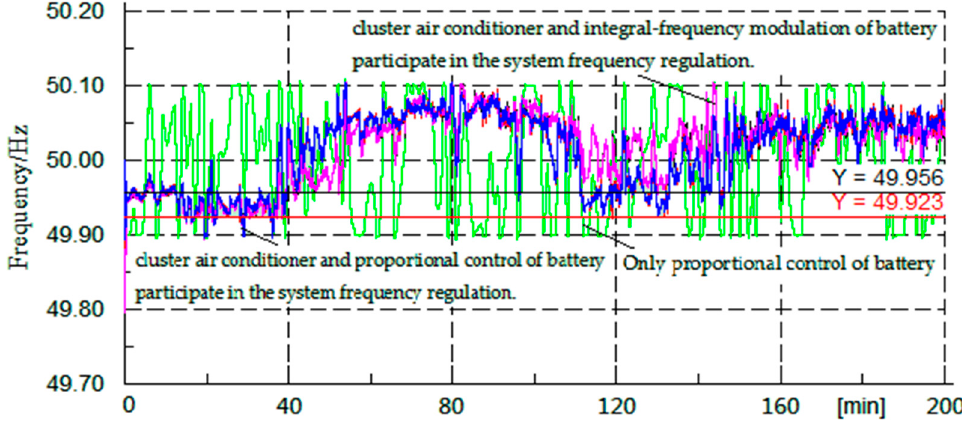
Figure 8. The system frequency curves with different frequency regulation methods of battery.